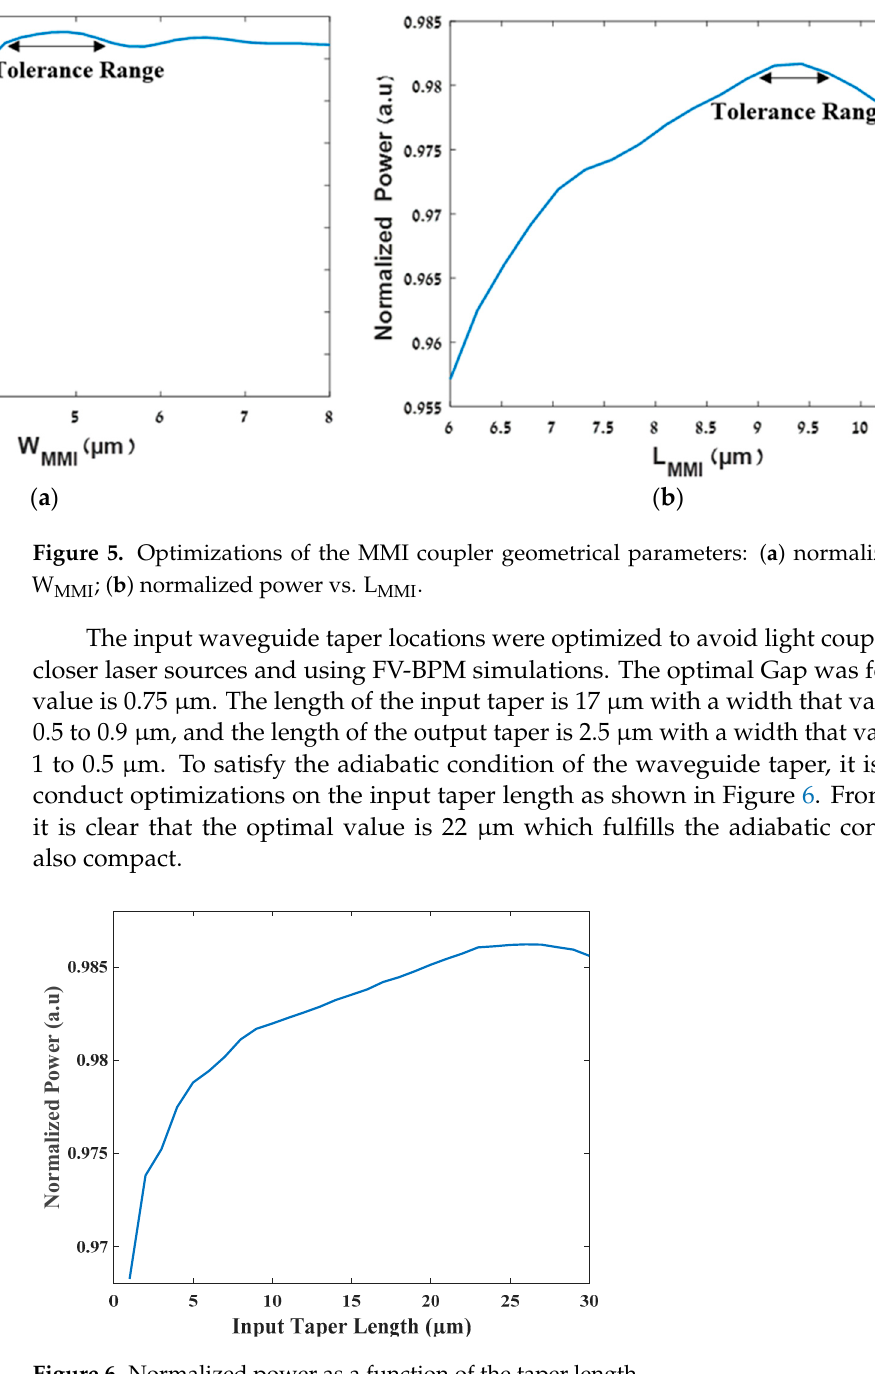
( b ) Figure 7. Intensity light propagation profile for the 4 × 1 MMI power combiner: ( a ) plane x-z under TE mode; ( b ) z-axis under TE mode.